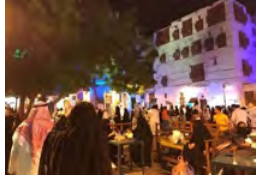
Figure 13. Show Cul de Sac as a social place